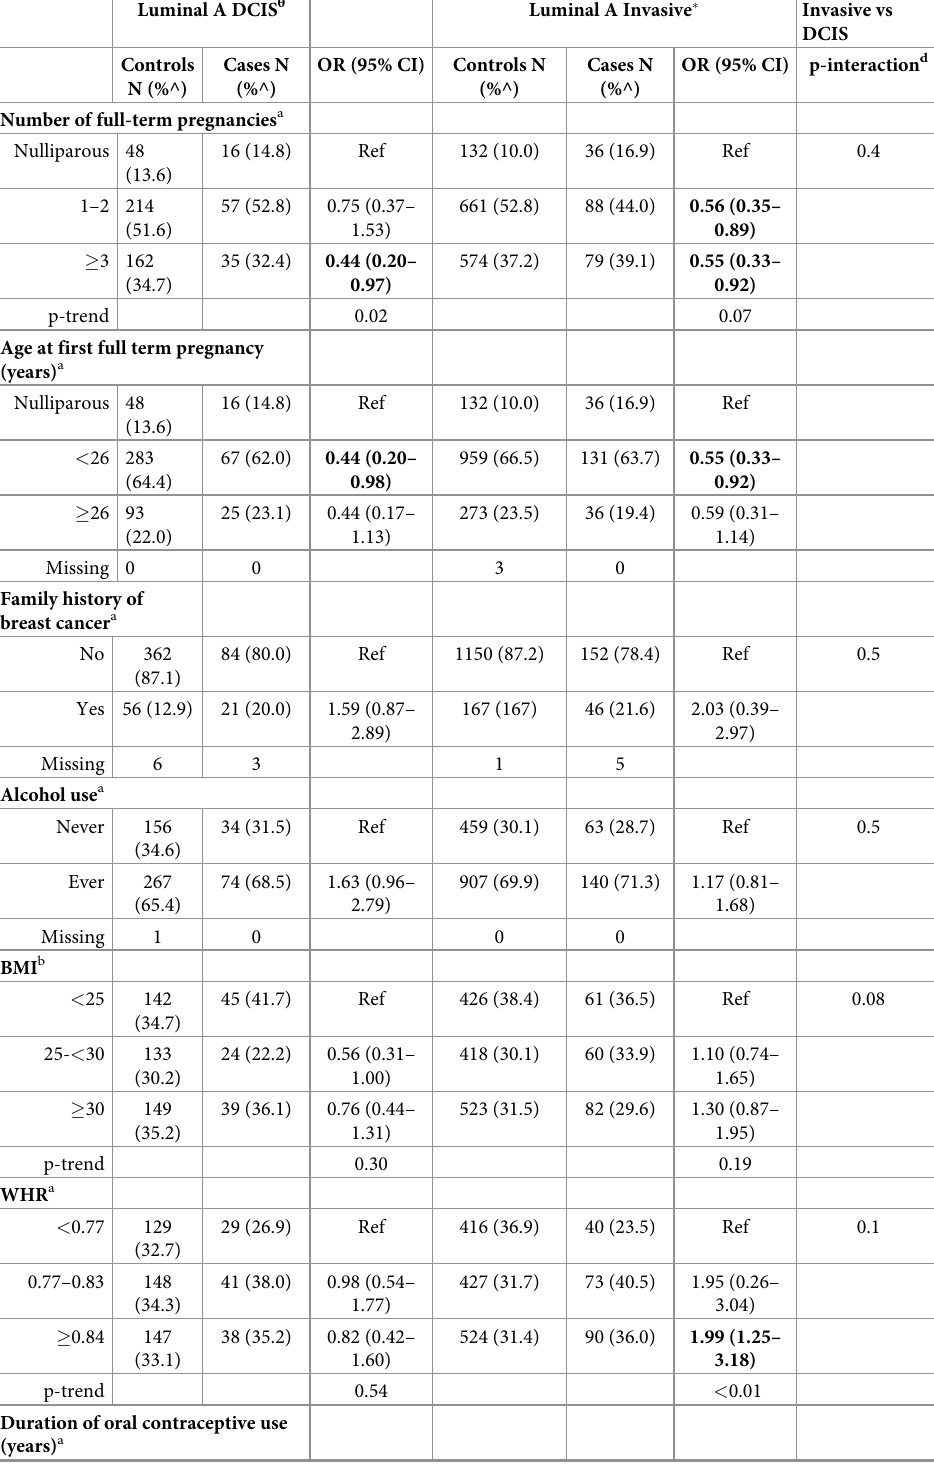
Table 2. Odds Ratios (OR) and 95% Confidence Intervals (95% CI) for screen detected Luminal A DCIS and inva- sive breast cancer cases (among women � 40 years of age) compared to the respective controls from the Carolina Breast Cancer Study, Phases1-2